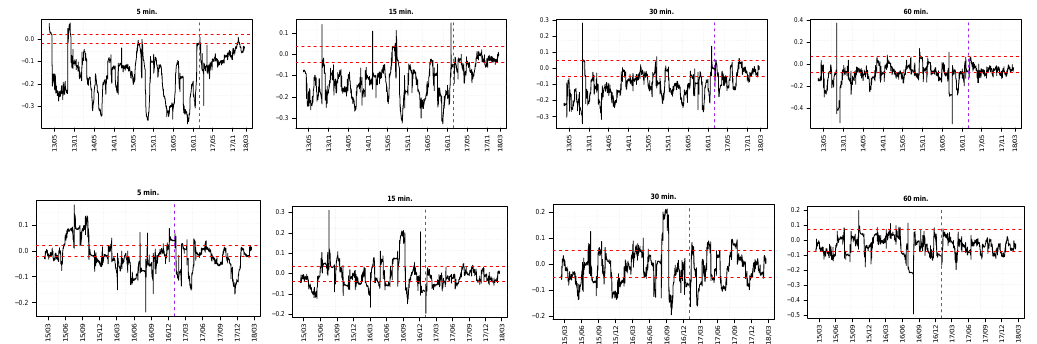
Figure 3. First order serial autocorrelation coefficient estimated using a fixed rolling windows of one month for Bitstamp (top figures) and Coinbase (bottom figures). Horizontal dashed lines indicate the 95% confidence interval. The dashed vertical line indicates the start of the Hype period at the begin of January 2017. Results are reported for Bitcoin logarithmic returns sampled at 5, 15, 30, and 60